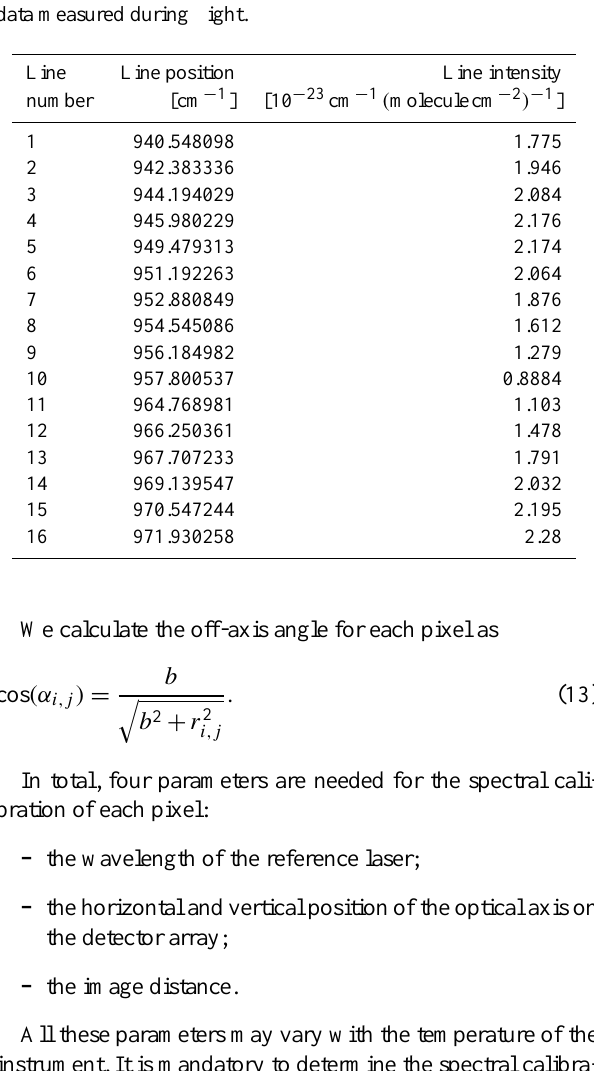
Table 1. The line position and intensity of the selected CO 2 lines from the HITRAN database used for the spectral calibration of the data measured during flight.